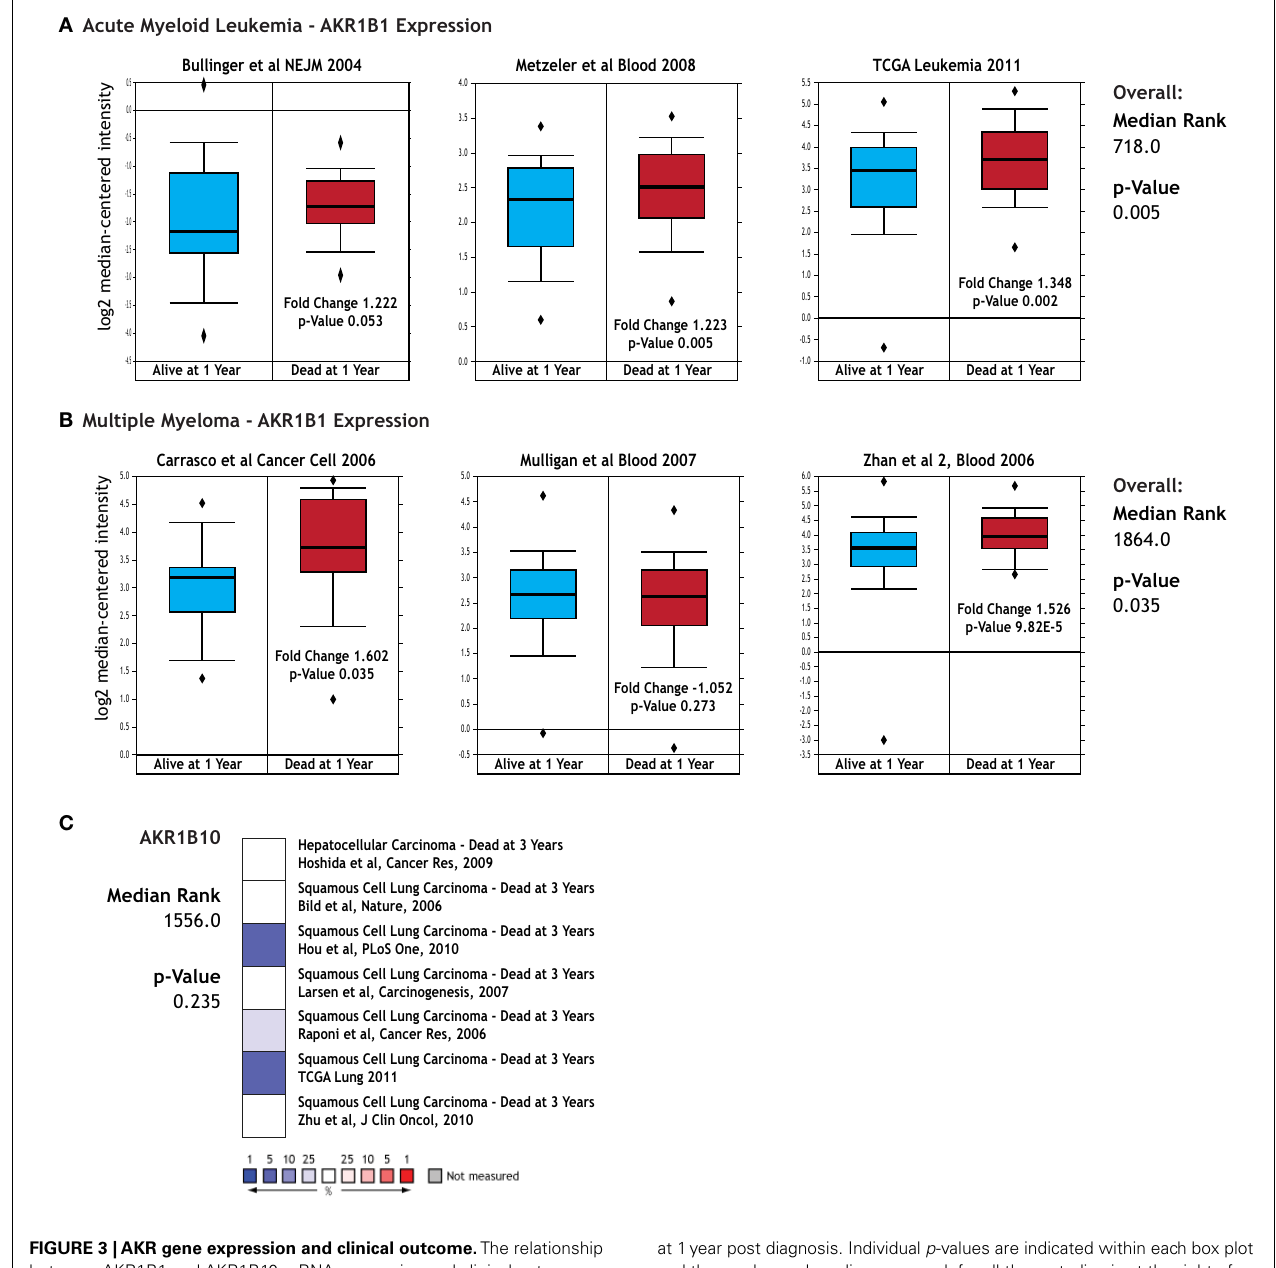
FIGURE 3 |AKR gene expression and clinical outcome. The relationship between AKR1B1 and AKR1B10 mRNA expression and clinical outcomes were examined using the Oncomine database. (A) Comparison of AKR1B1 expression in acute myeloid leukemia patients who were alive (blue boxes) and dead (red boxes) at 1year post diagnosis. Individual p -values are indicated within each box plot and the p -value and median gene rank for all three studies is at the right of the panel. (B) Comparison of AKR1B1 expression in multiple myeloma patients who were alive (blue boxes) and dead (red boxes)